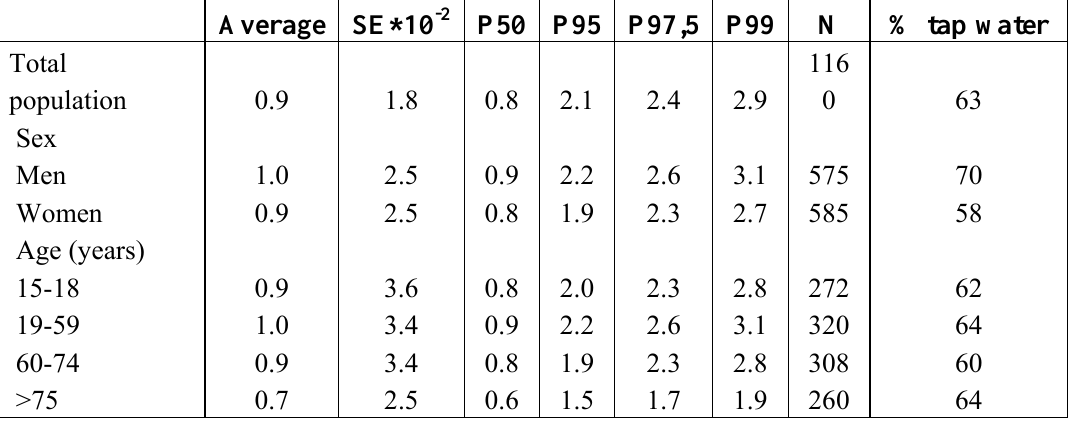
Table 4. Fluoride intake (mg/day) through consumption of non-alcoholic beverages in the Walloon region (Brussels included), by sex and age group (Food Consumption Survey,